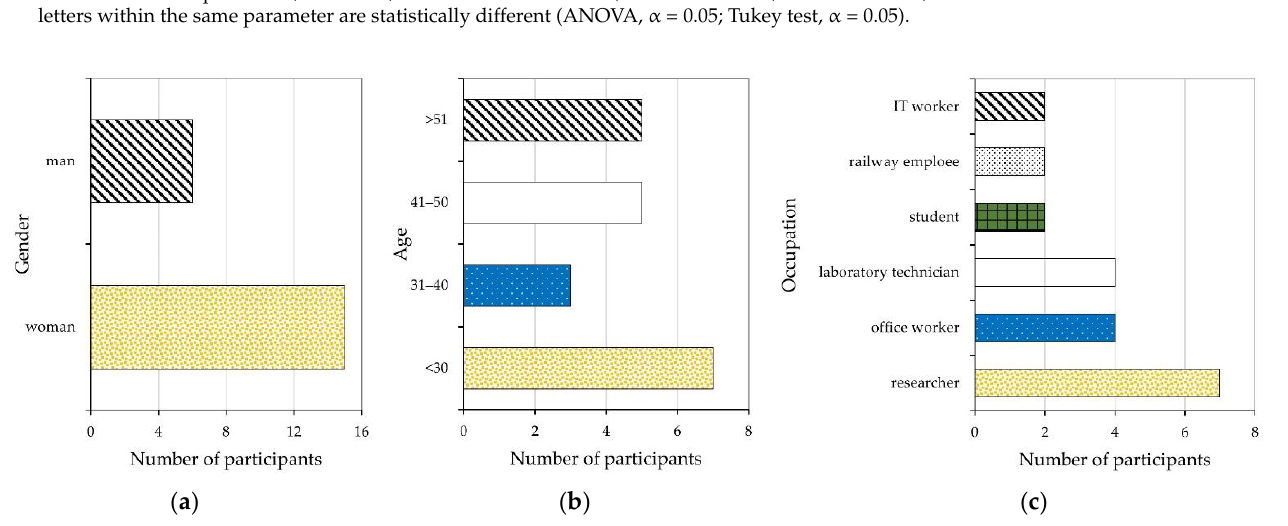
Figure 1. Study group characteristics: ( a ) gender, ( b ) age, and ( c ) occupation.